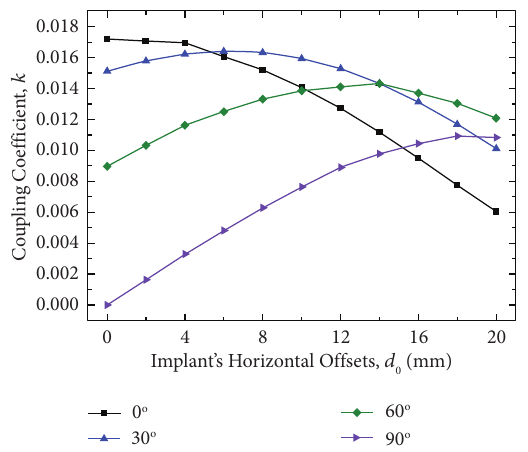
Figure 8: The simulated values of k for the inductive links at 30MHz versus Rx coil’s horizontal offsets ( d 0 ) and vertical angle deviation ( θ